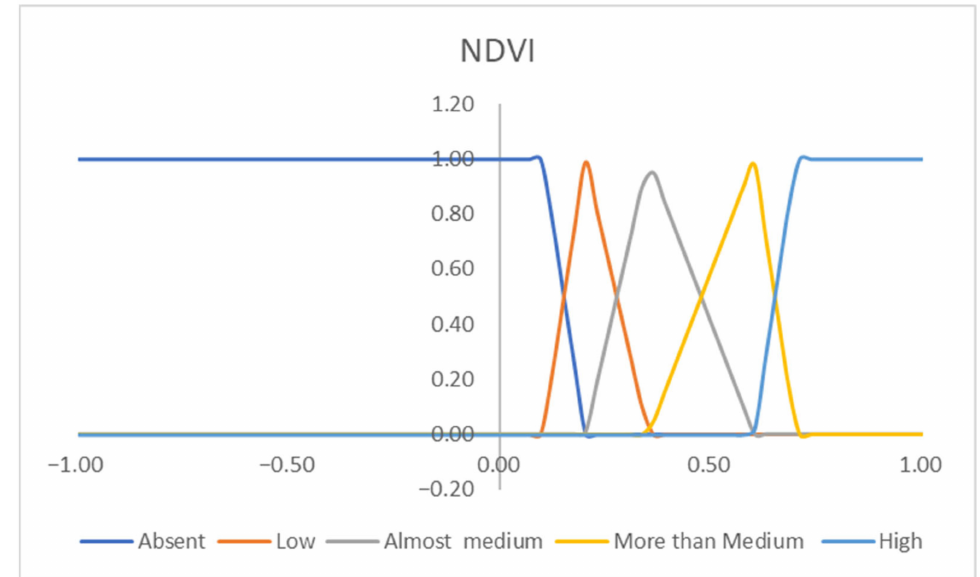
Figure 14. The second fuzzy partition of NDVI given by 5 fuzzy